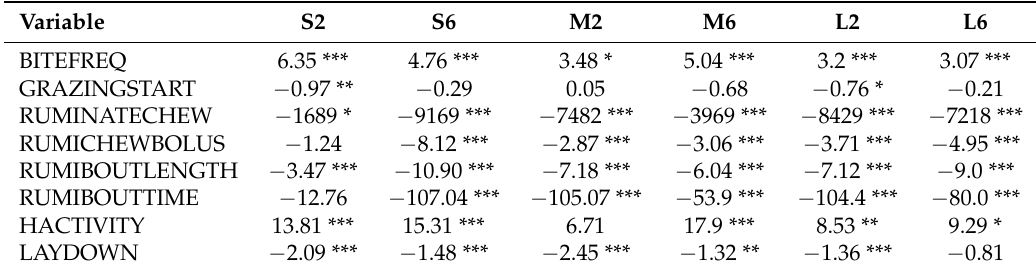
Table A1. Independent samples t -tests for significant differences of means of each predictor in the